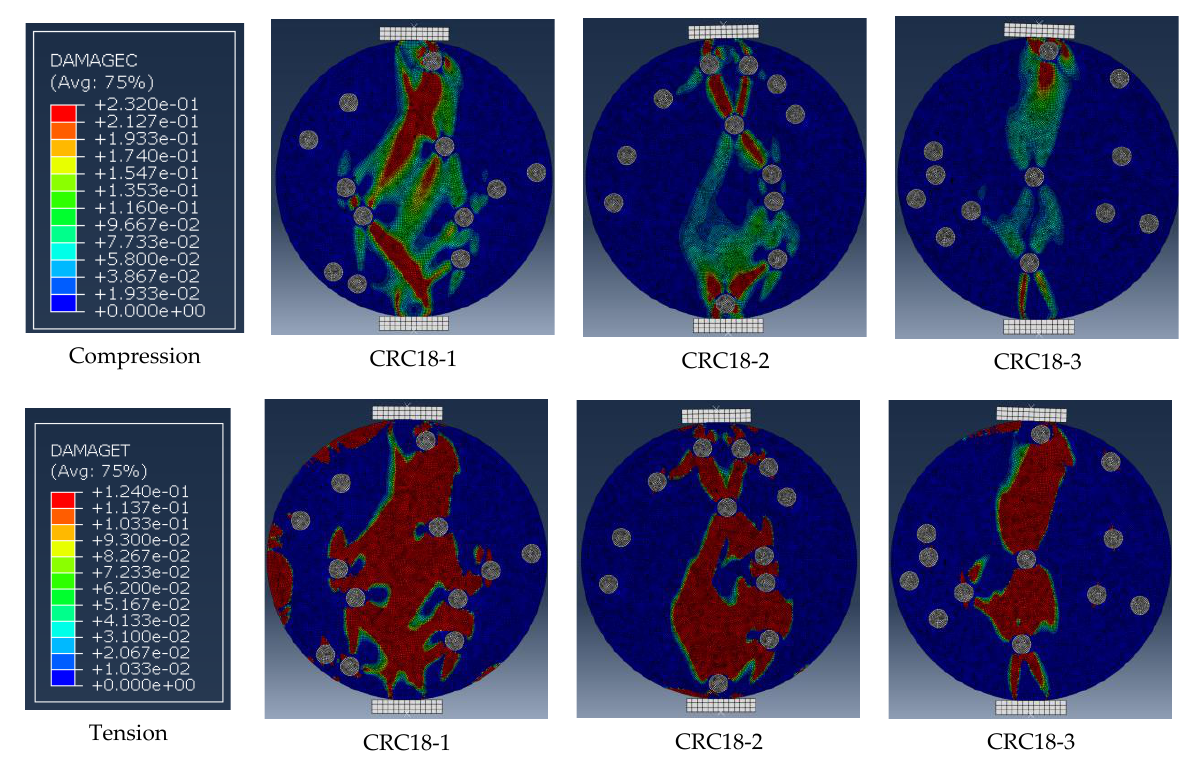
Figure 14. Compressive and tensile damage of three CRM 18 specimens added with 7 mm circular rubber particles.